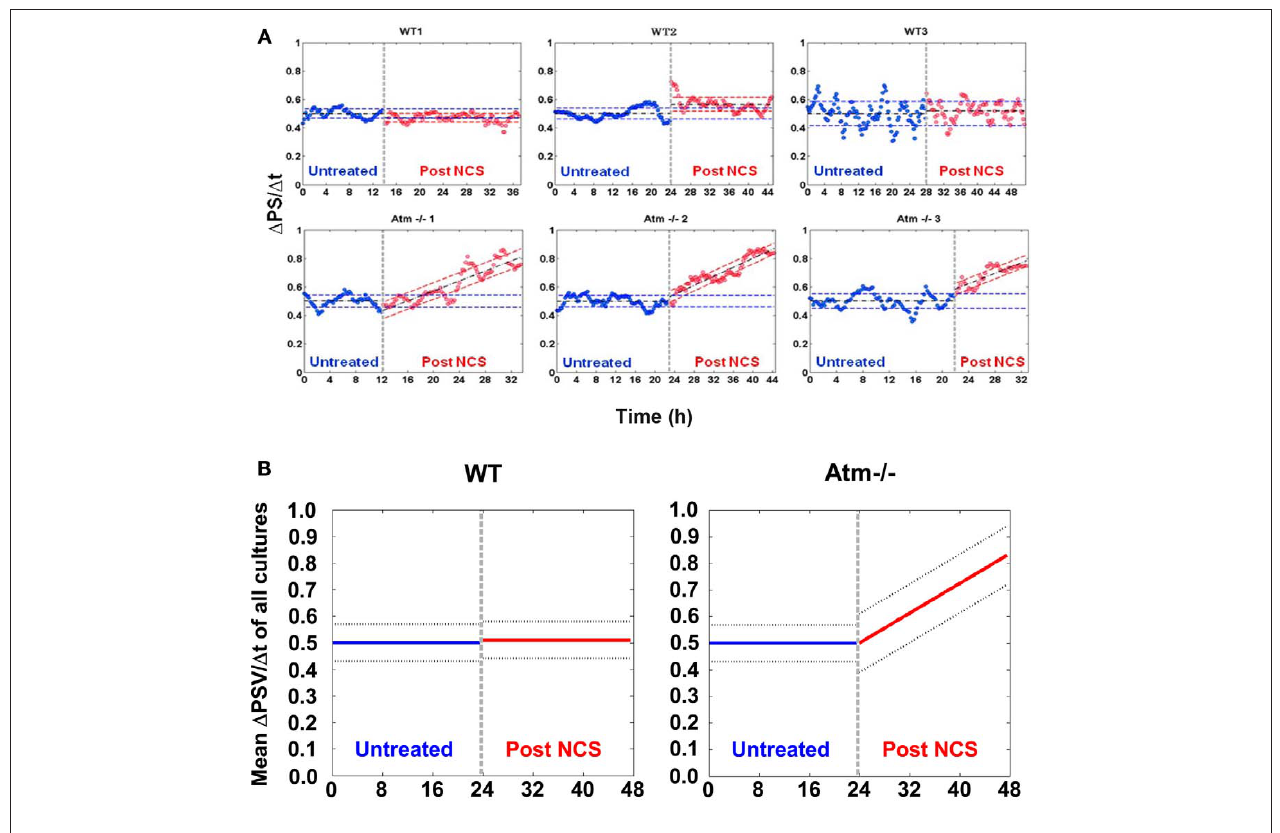
is normalized so that the mean value is exactly 0.5. As opposed to WT cultures, Atm − / − networks presents an increase in variation following the induction of DNA damage with Neocarzinostatin (NCS). The dashed black line following NCS application represents the least mean square (LMS) fit for the samples rather than the mean value. In (B) we show the mean levels of the slope and STD of the results for the three WT and the three Atm − / − networks